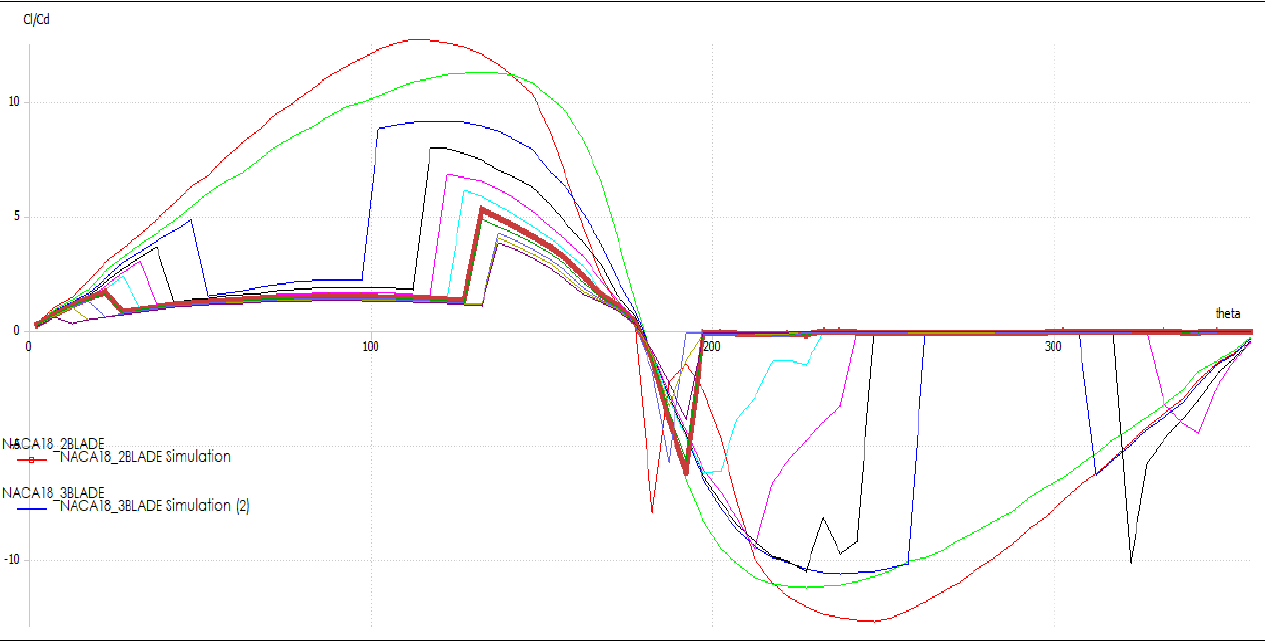
Fi gure 32. Cl/Cd vs theta plot of top-section for TSR